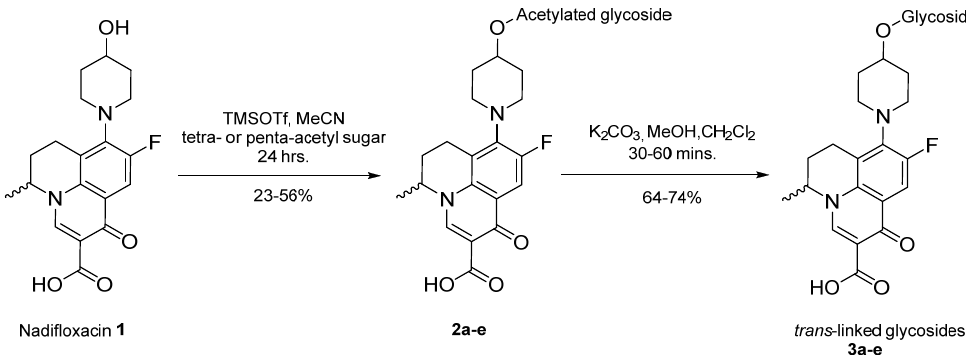
Scheme 1. Synthesis of trans -linked nadifloxacin glycosides, specifically α - L -arabinofuranoside ( 3a ), β - D -galactopyranoside ( 3b ), β - D -glucopyranoside ( 3c ), α - D -mannopyranoside ( 3d ) and β - D